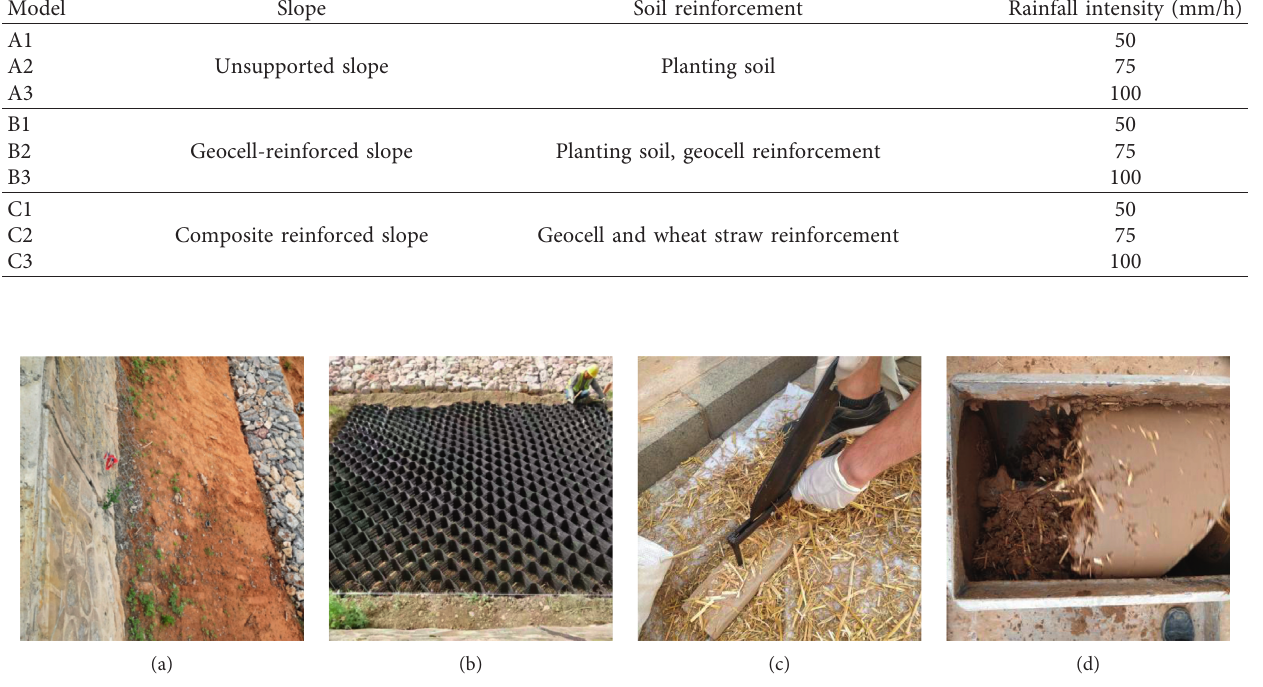
Figure 1: Modelling material preparation: (a) planting soil in the field; (b) geocell structures; (c) wheat straw cutting; (d) mixture of straw with the planting soil.